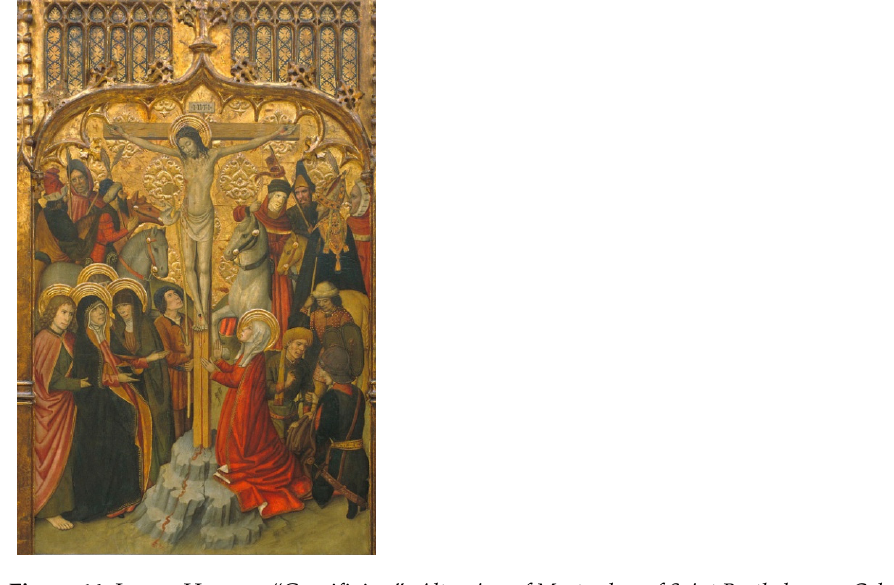
Figure 14. Jaume Huguet. “Crucifixion”, Altarpiece of Martyrdom of Saint Bartholomew; Calvary;